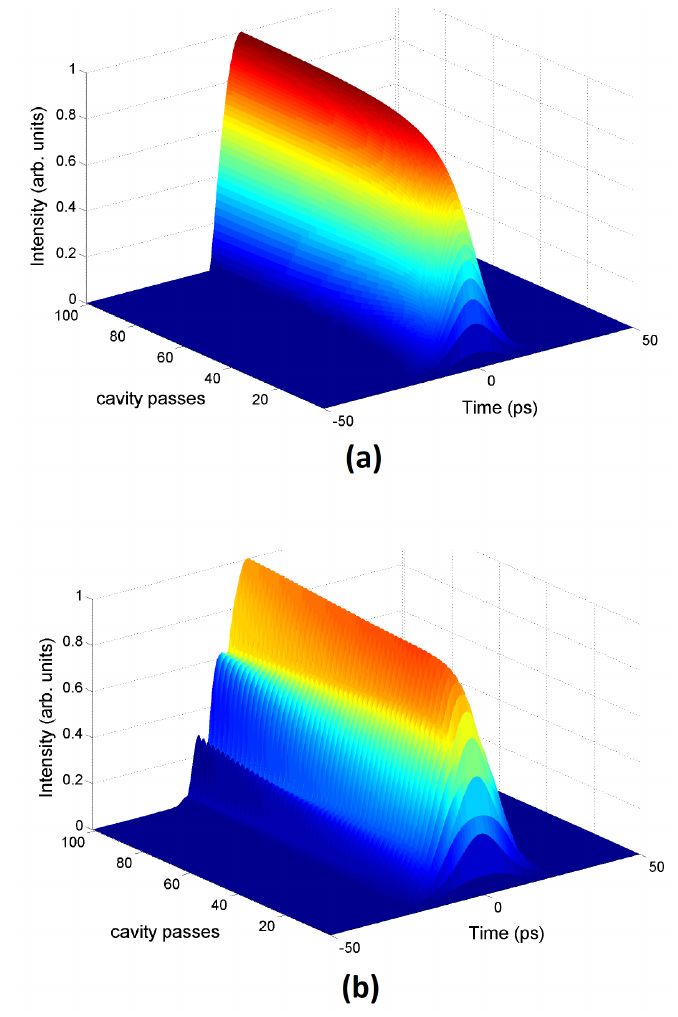
Figure 4. Evolutions of parabolic intensity profiles in a mode-locked fiber laser with: ( a ) the interacavity pulse shaper turned off, ( b ) the interacavity pulse shaper turned